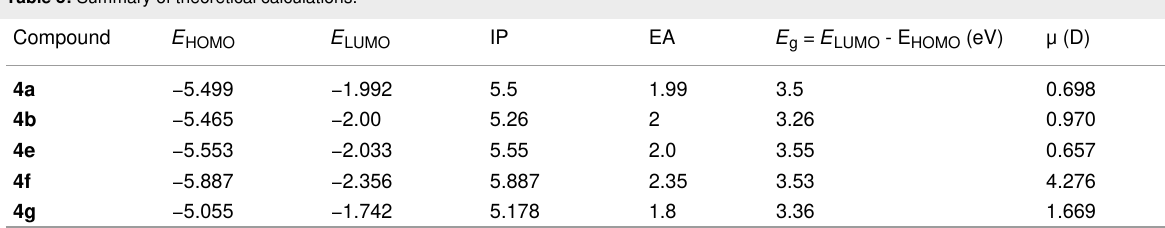
Table 5: Summary of theoretical calculations. a